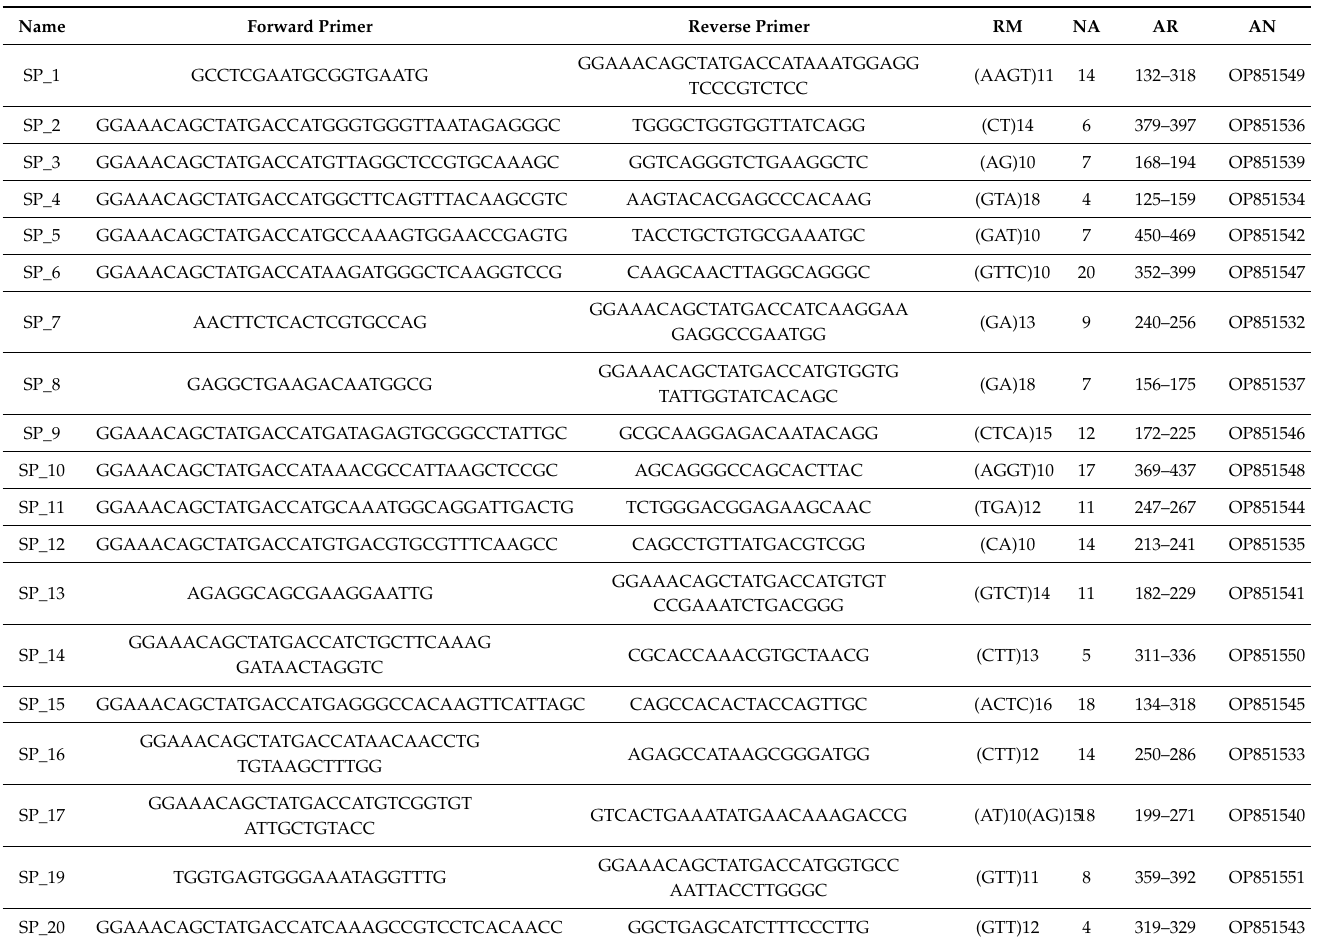
Table 1. Characteristics of novel microsatellite loci developed for S. pistillata : locus name, forward and reverse primer sequences (5 (cid:48) to 3 (cid:48) ); RM = repetitive motive, NA = number of alleles; AR = alleles range (bp); AN = GenBank accession